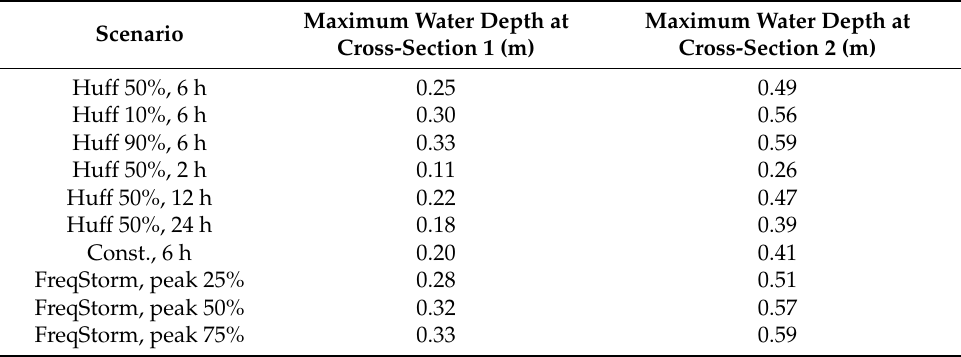
Table 5. Comparison of maximum water depths for cross-sections 1 and 2 for different scenarios for the 10-year return